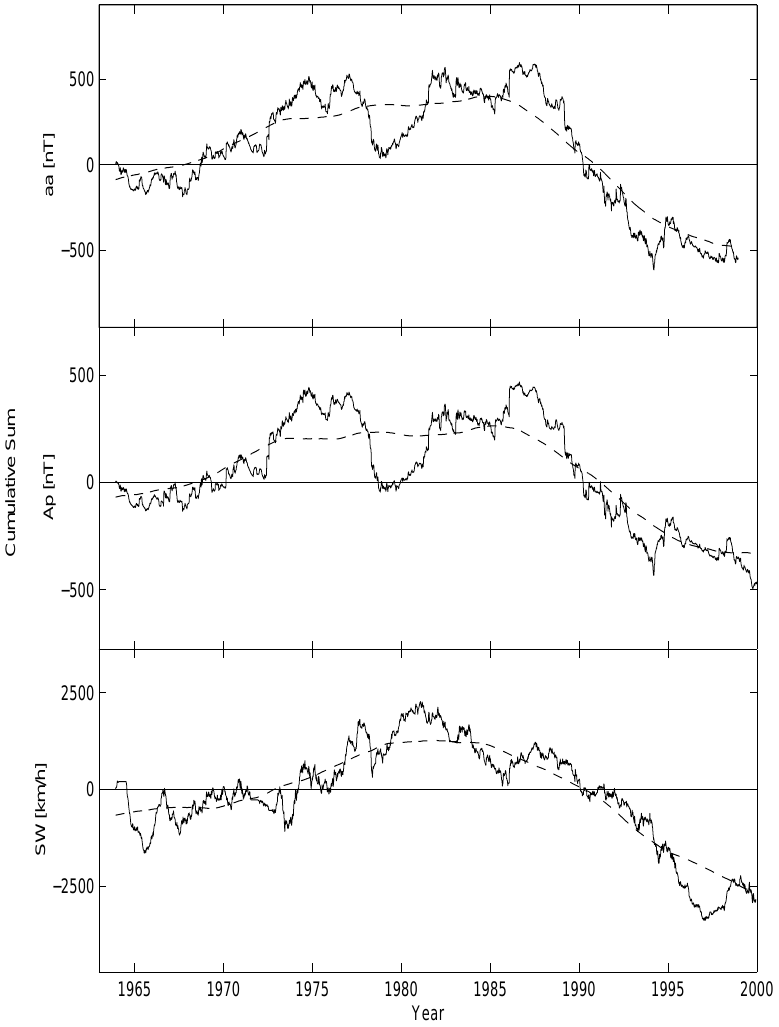
Fig. 4. Cumulative sum of weekend- weekday differences for the aa (top) and A p (center) geomagnetic indices and for the solar wind speed (bottom). Running 10-year means are depicted as dashed curves. Horizontal lines depict the zero levels of cumulative